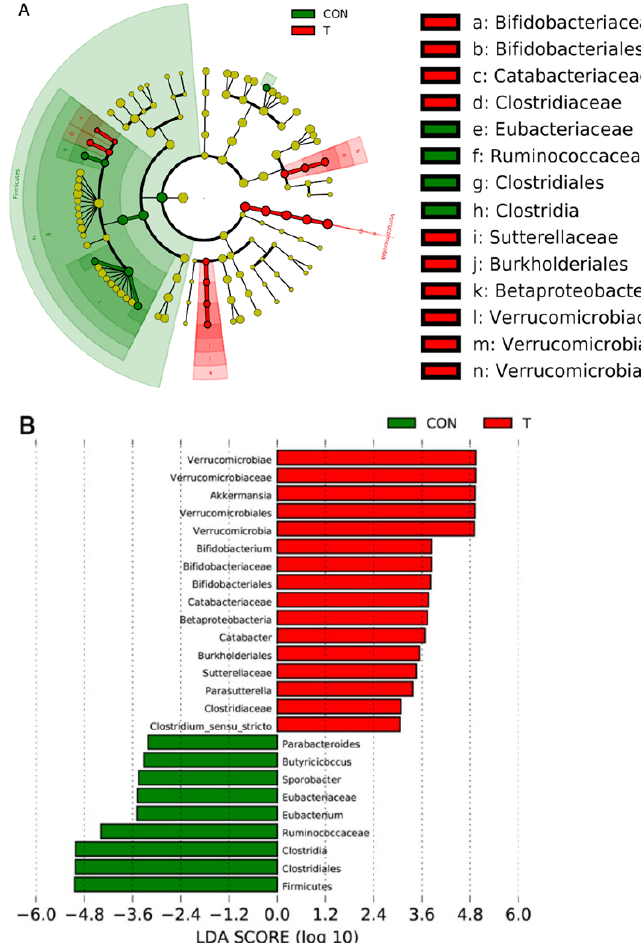
Figure 11. ( A ) Evolutionary branching of intestinal flora of mice in groups of control and treatment; ( B ) Comparison of linear discriminant analysis (LDA) of intestinal flora of mice in groups of control and treatment. In ( A ), the circles radiating from the inside out represent the classification level from phylum to genus (or species). Each small circle at a different classification level represents a classification at that level. The red nodes represent the microbiome that plays an important role in the treatment group, and the green nodes represent the microbiome that plays an important role in the control group. Species with no significant difference are yellow nodes. ( B ) shows species with differences in LDA scores above the set point (2.0), i.e., statistically significant differences.